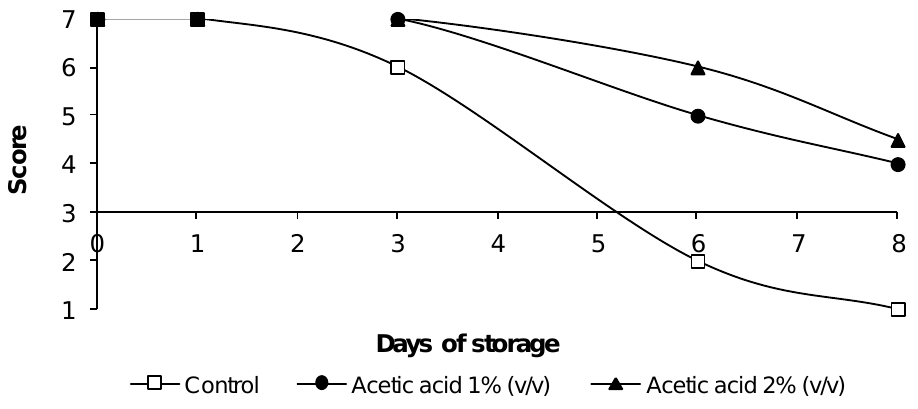
Figure 2. The evolution of color in chicken legs treated with acetic acid. The data are the mean values of six replicates.